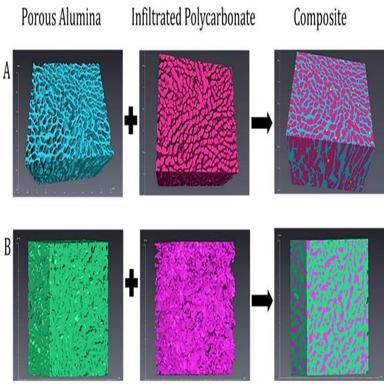
3D MicroCT images of the porous alumina preform, infiltrated polycarbonate phase and the final interpenetrating phase composite material. (A) Al2O3-PC-20% blue represents the ceramic phase and pink the polymer. (B) Al2O3-PC-30%, green represents the ceramic phase and pink the polymer phase. (For interpretation of the references to color in this figure legend, the reader is referred to the web version of this article.)